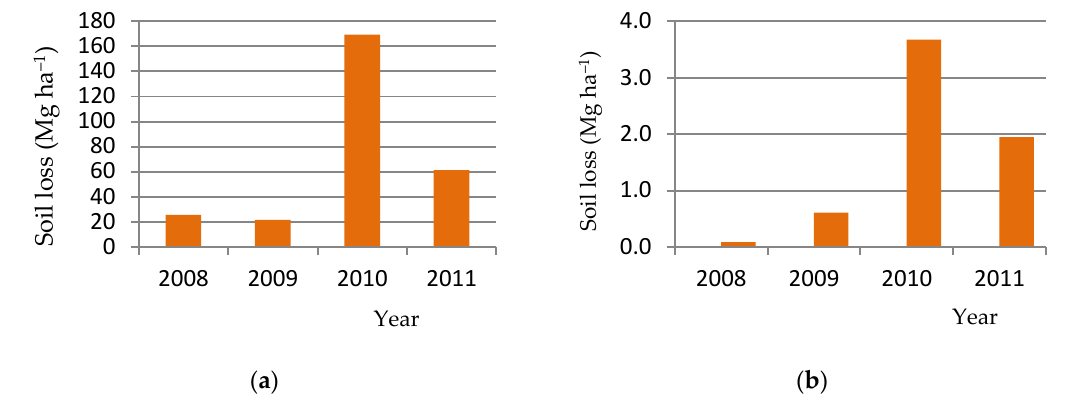
Figure 7. Soil losses during surface ( a ) and subsurface ( b ) runoff in 2008–2011.